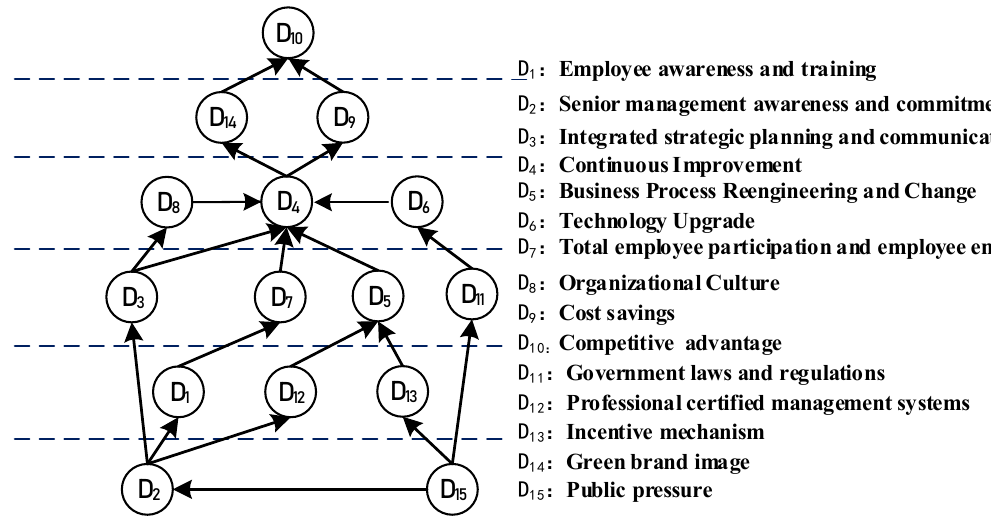
Figure 5. Hierarchy of indicators of driving factors.